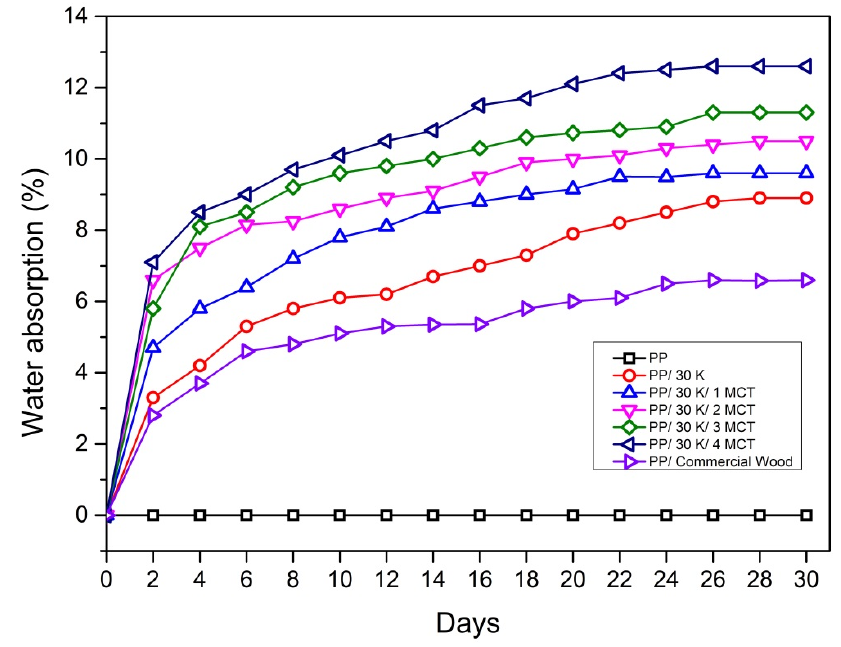
Figure 5. Water absorption of PP and PP/kenaf/MWCNT composites .